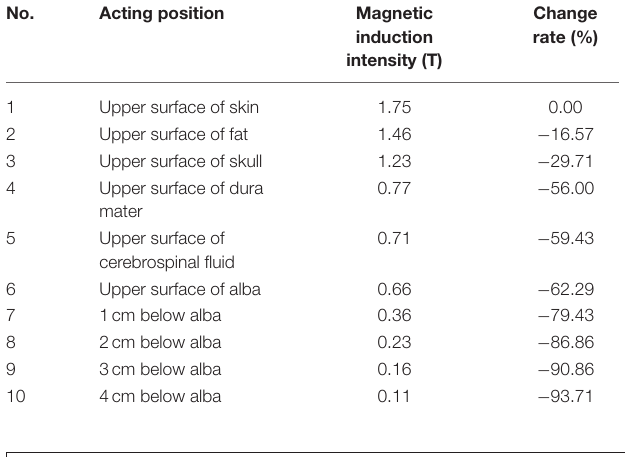
TABLE 4 | Distribution of magnetic induction intensity of the coil in the layered model of brain.